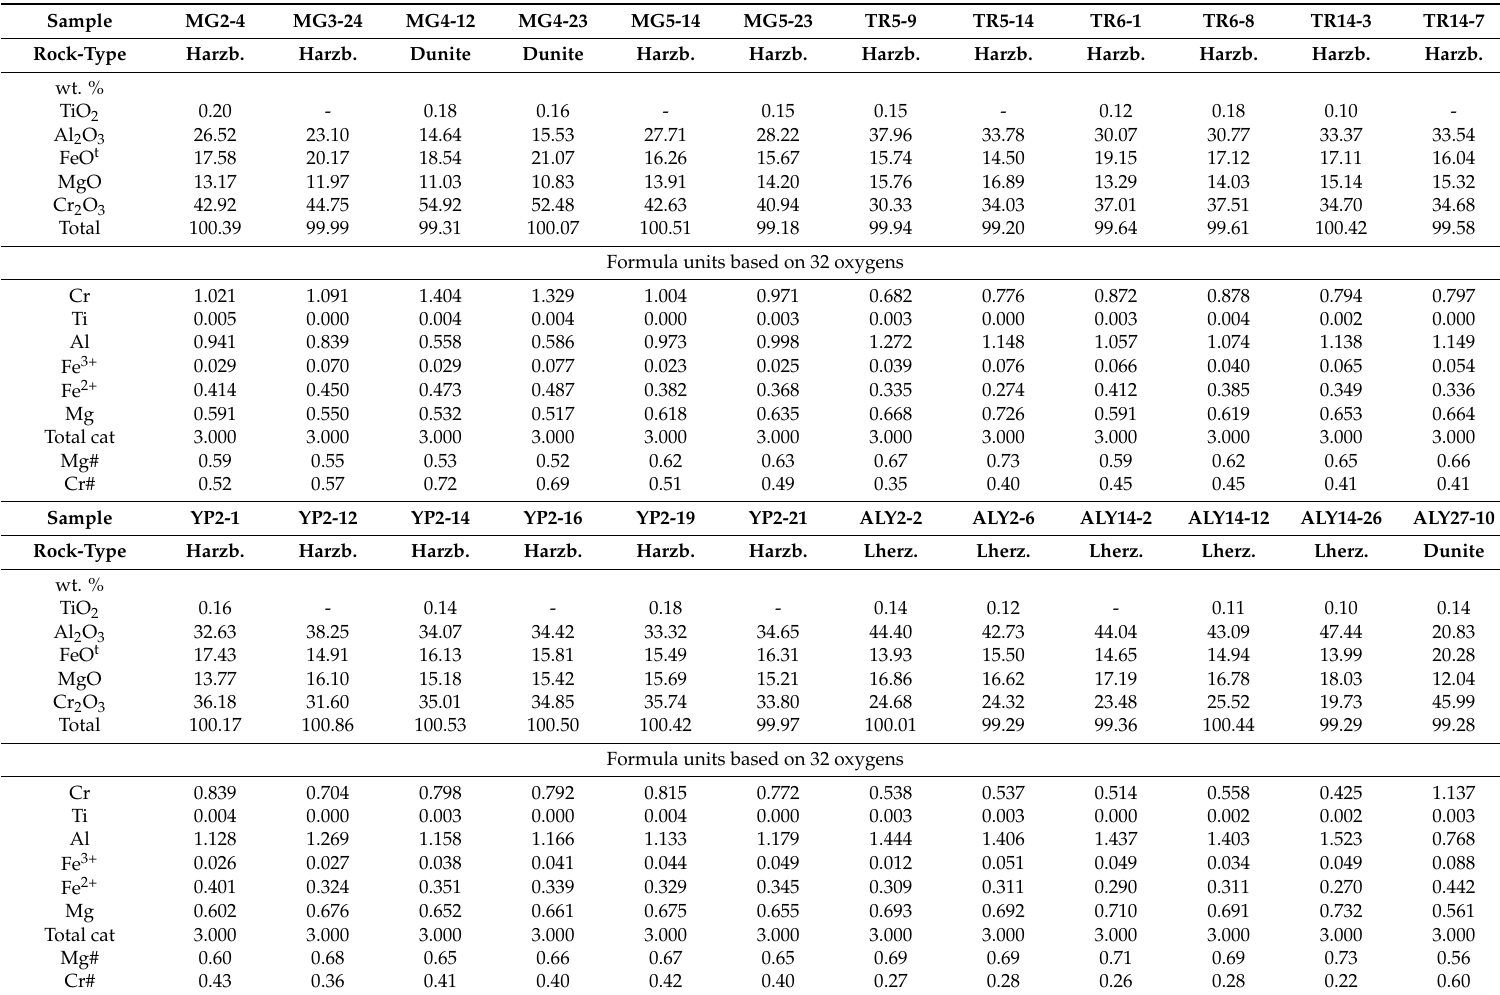
Table 1. Representative electron microanalyses (wt.%) and atomic proportions of Cr-spinels from peridotites of Megaplatanos (MG), Tragana (TR), Ypato (YP) and Alyki